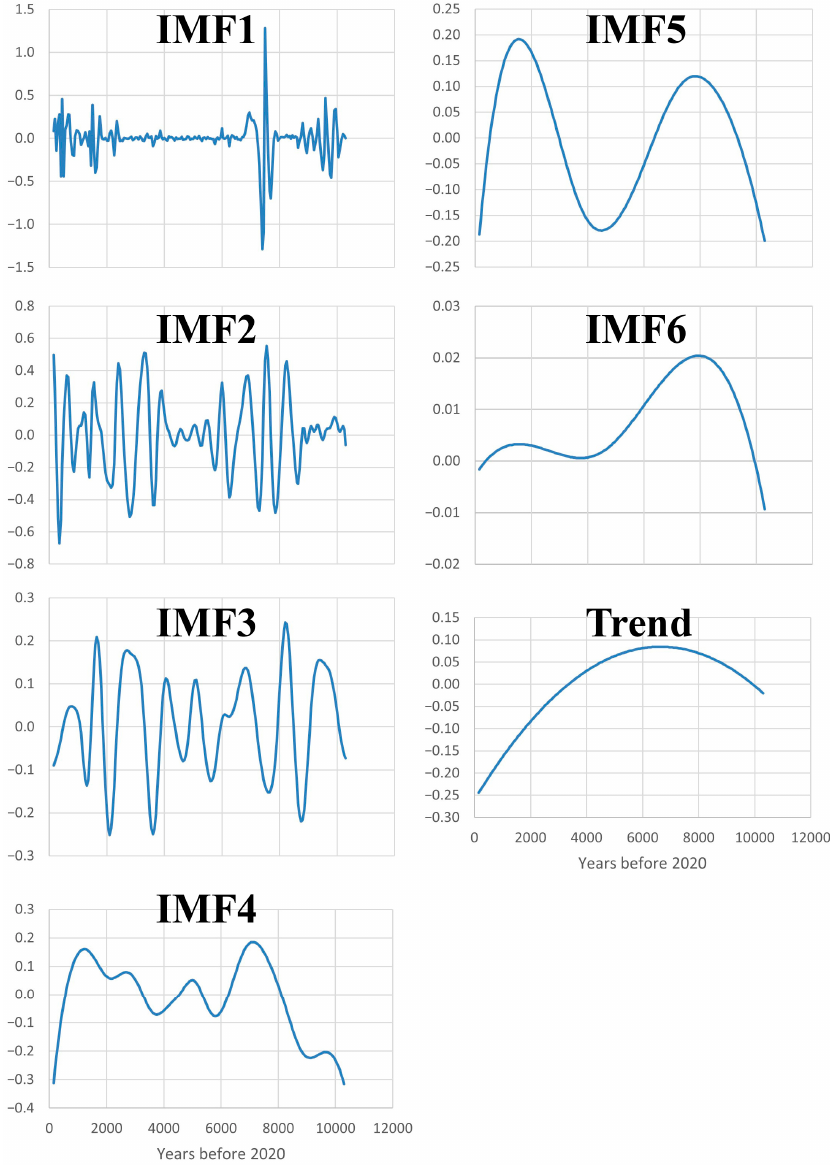
Figure 14. EEMD of the deseasonalized and detrended reconstructed mean July air temperatures timeseries in six IMFs and a trend.